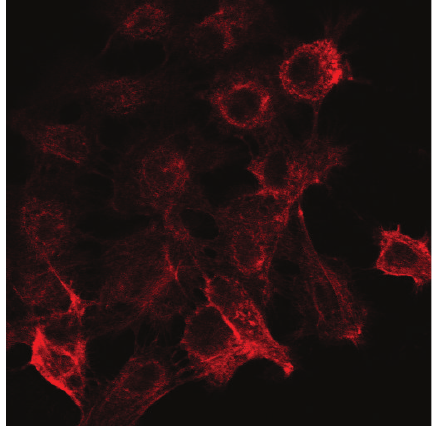
Figure 12: Immunofluorescence image of ERM cells using an antibody to VEGF at 48 hours. ERM cells were positive for VEGF at 48 hours stretch group.